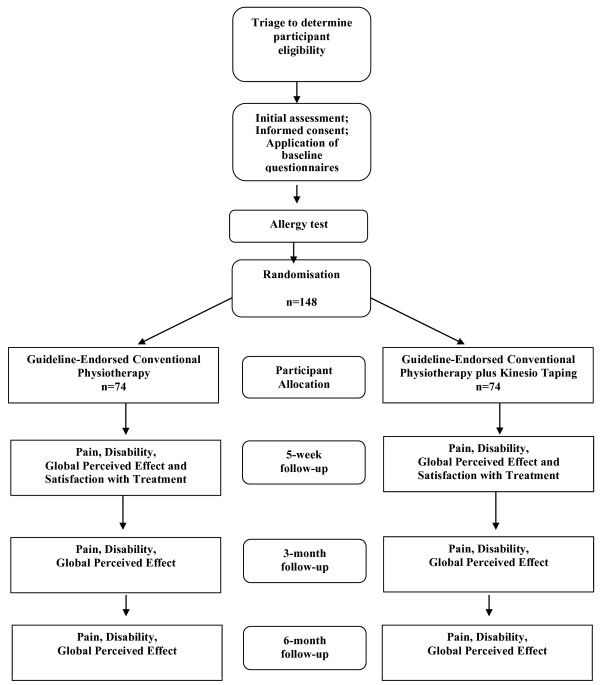
Study flow diagram.